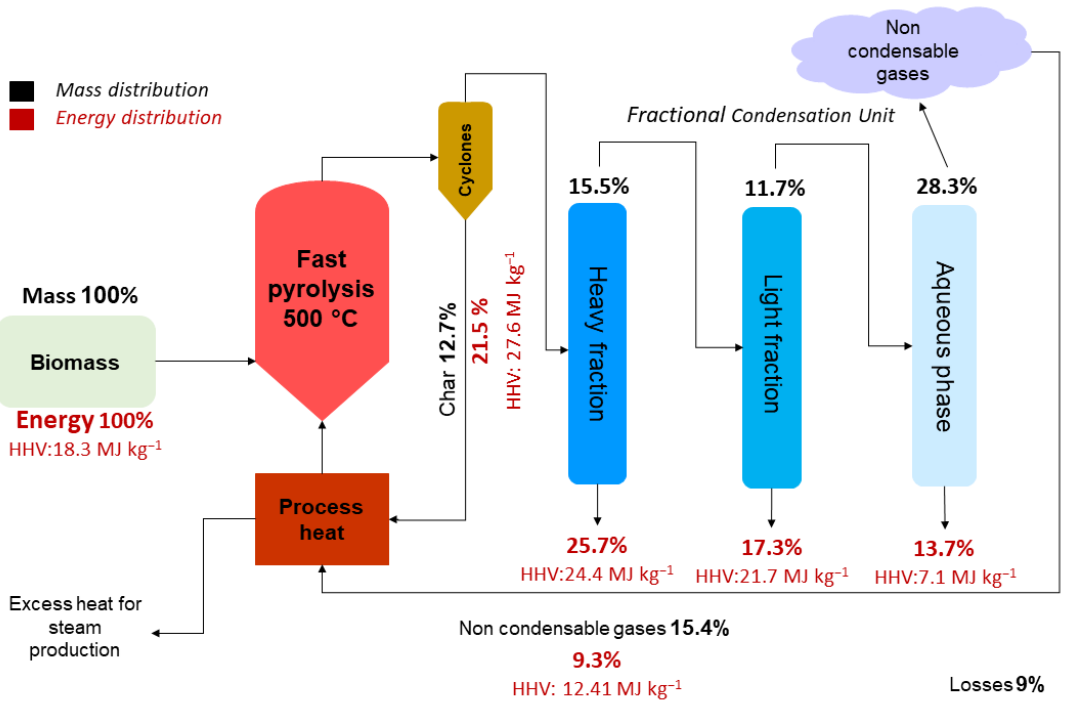
Figure 10. Mass and energy balances of a commercial-scale plant with a fractional condensation system. Data in black referring to the mass distribution, data in red to the energy distribution.